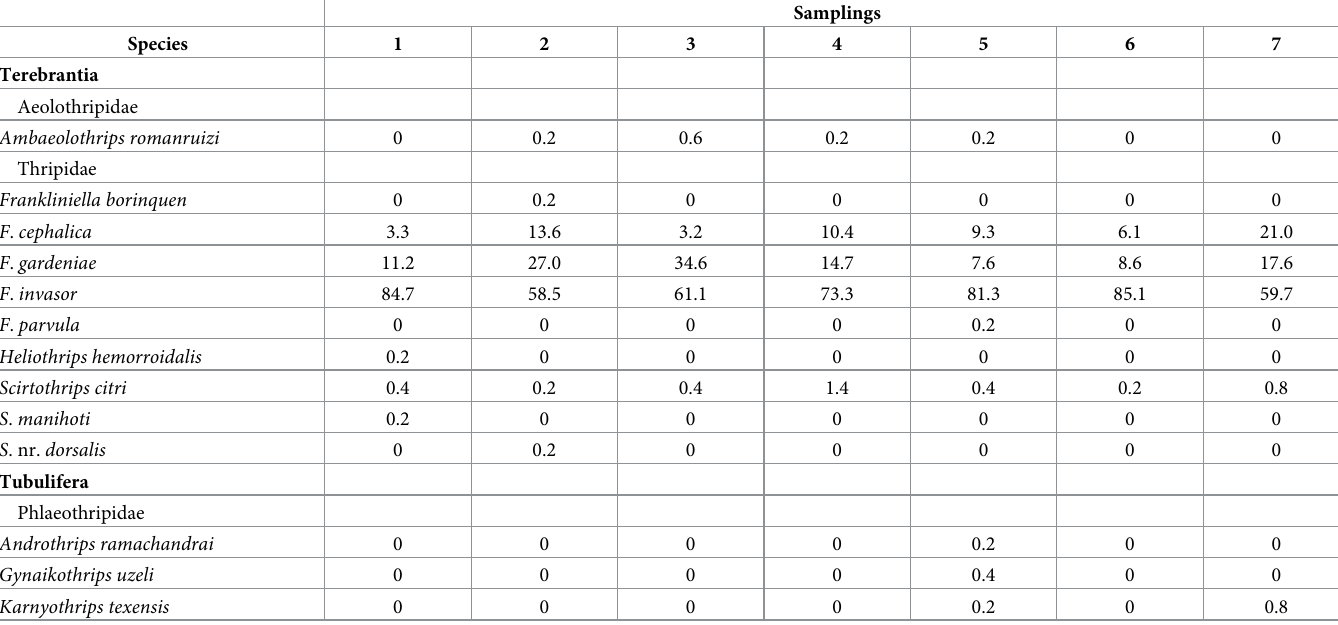
Table 2. Thrips from mango inflorescences.